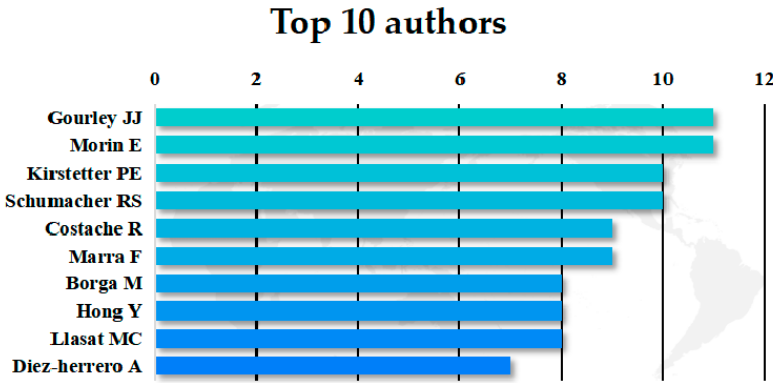
Figure 7. Influence analysis of prolific authors.